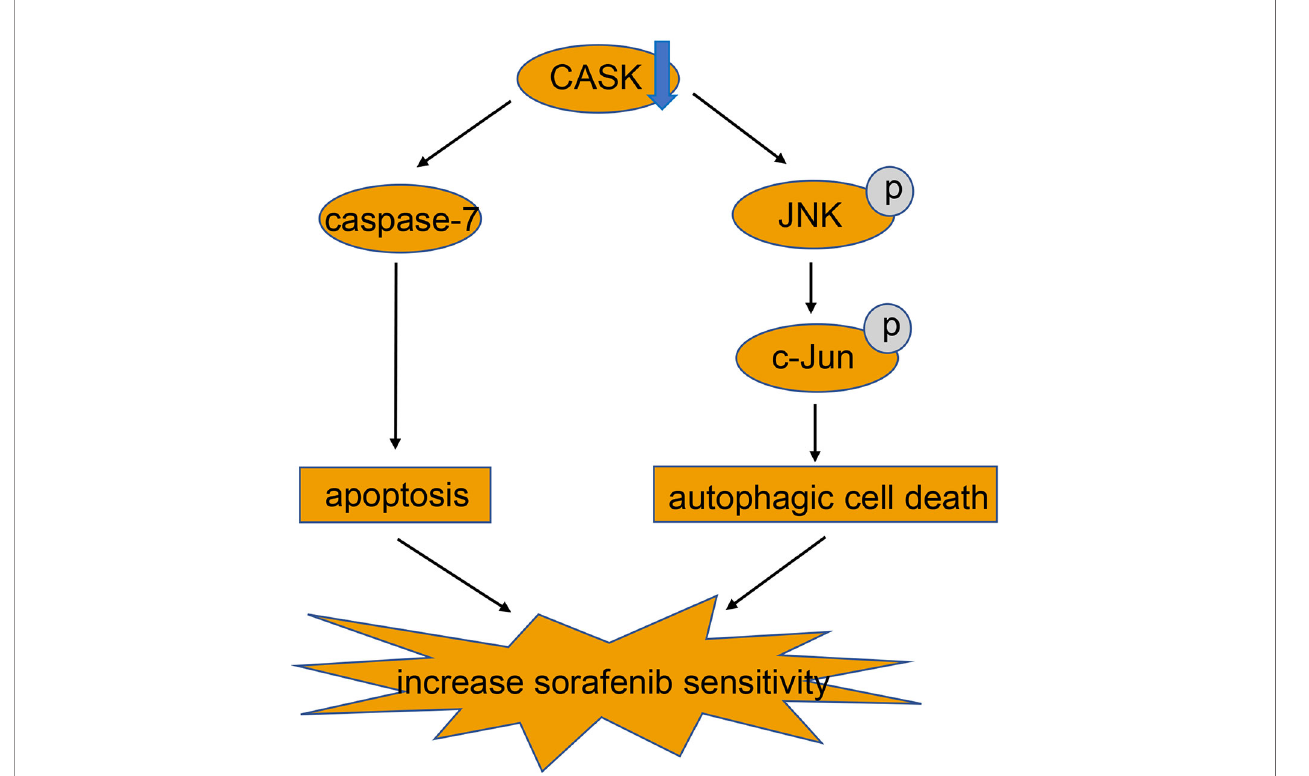
FIGURE 6 | Mechanistic model for CASK regulation of sorafenib-induced apoptosis and autophagy in